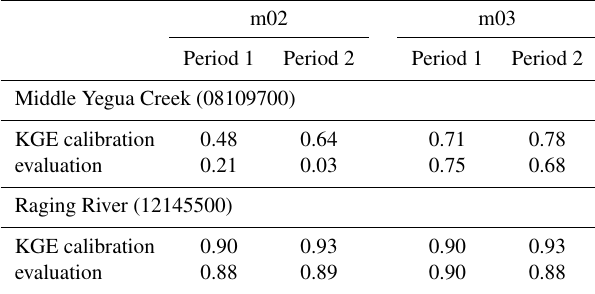
Table 1. Kling–Gupta efficiency (KGE) scores obtained using two different definitions of calibration and evaluation periods. The columns labelled “Period 1” refer to a calibration period that ranges from 1 January 1989 to 31 December 1998 and an evaluation pe- riod that covers 1 January 1999 to 31 December 2009 (i.e. values are replicated from Fig. 1). The columns labelled “Period 2” show results obtained from calibrating the models on data from 1 Jan- uary 1999 to 31 December 2009 and evaluating the models on